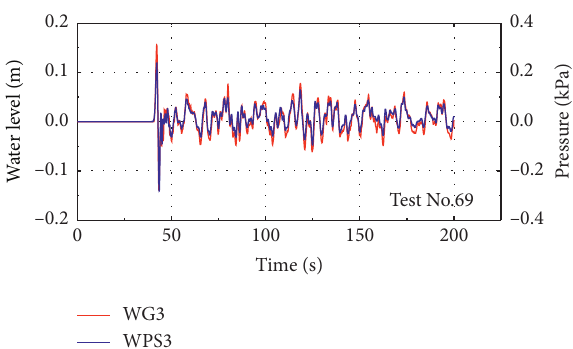
Figure 10: The curves of water surface elevation and impulse wave pressure from Test No. 69 with l � 1.0 m, w � 1.0 m, s � 0.6 m, h �